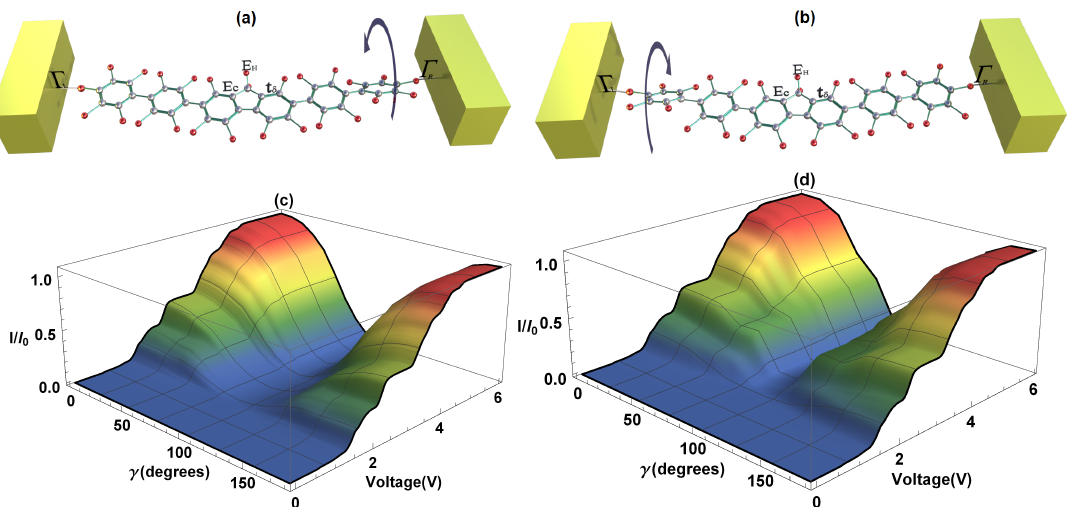
Figure 6. ( a ) Representation of the right dihedral angle rotation, ( b ) representation of the left dihedral angle rotation, ( c ) current as a function of bias voltage and of the right dihedral angle rotation, ( d ) current as a function of bias voltage and of the left dihedral angle